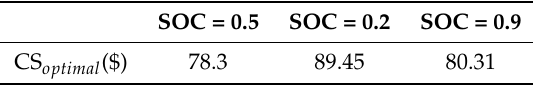
Table 5. The final value by DP in